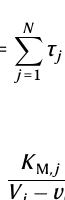
standard deviation. d NPLs assembled with 7E at Opt 2 ratios in batch (enzymes mixed together fi rst followed by NP addition) or separately where each enzyme added to 1/7th the NPL amount at the same concentration and ratio present in batchandthencombinedtogetherpriortotheassaystart;designatedby “ separate assembly ” . e NPLsassembledwith7E-Opt2ratios.Theorderofenzymeadditionto NPLs varied as indicated. Forward assembly added NP fi rst, followed by Glk, then PGI, PFK, etc. Backward added NP fi rst, followed by PGK, then GPD, etc. The batch added all enzymes at the same time, followed by NP, then mixed. f 520 QDs assembled with 7E-Opt 2 ratios. Forward assembly, backward assembly, and free prepared as above. Forward QD/enzyme stepwise added 1/7th QD followed by the fi rst enzyme (Glk), then 1/7th QD followed by the second enzyme (PGI), and so on with 10min between addition. Reaction NAD + =1.13mM. NP/QD concentration